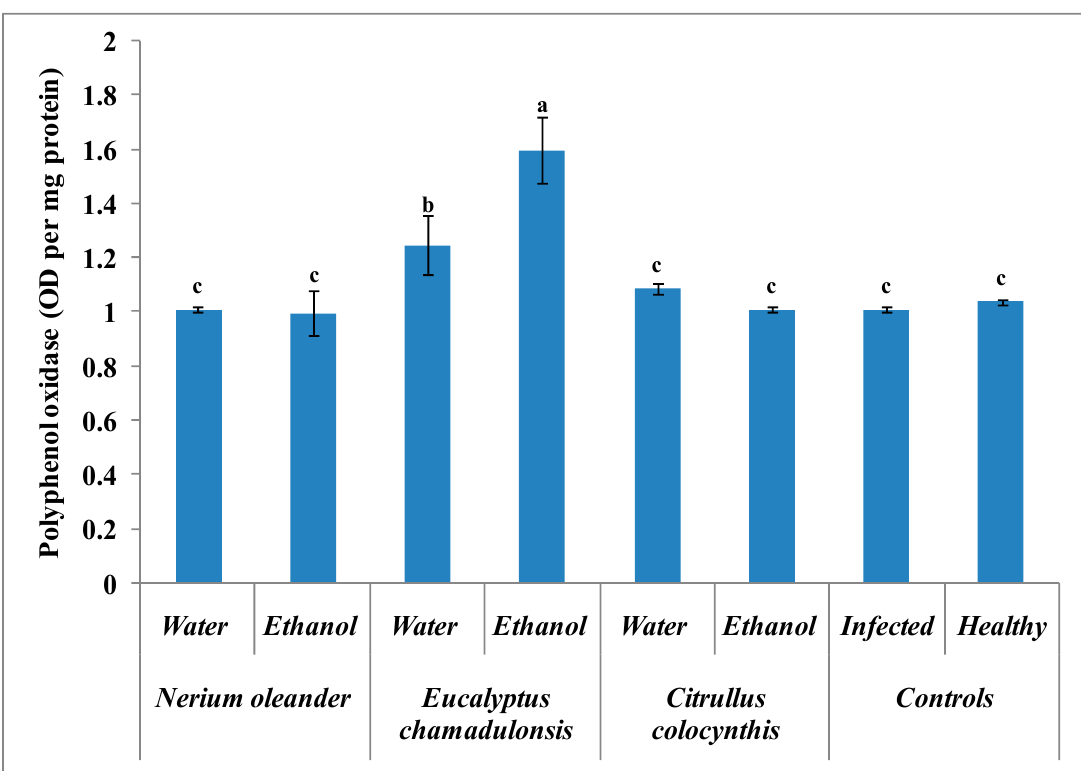
Figure 5. Effect of 15% concentrations of plant extracts of Nerium oleander, Eucalyptus chamadulonsis and Citrullus colocynthis on polyphenol oxidase activity as optical density (OD) per mg protein of ‘Super Marmande’ tomato after 7 days of treatment with the extracts and inoculated with Xanthomonas axonopodis pv. vesicatoria PHYXV3. Four replicates were used for each treatment. Columns with the same letters are not significantly different according to Fisher’s protected least significant difference at p ≤ 0.05.